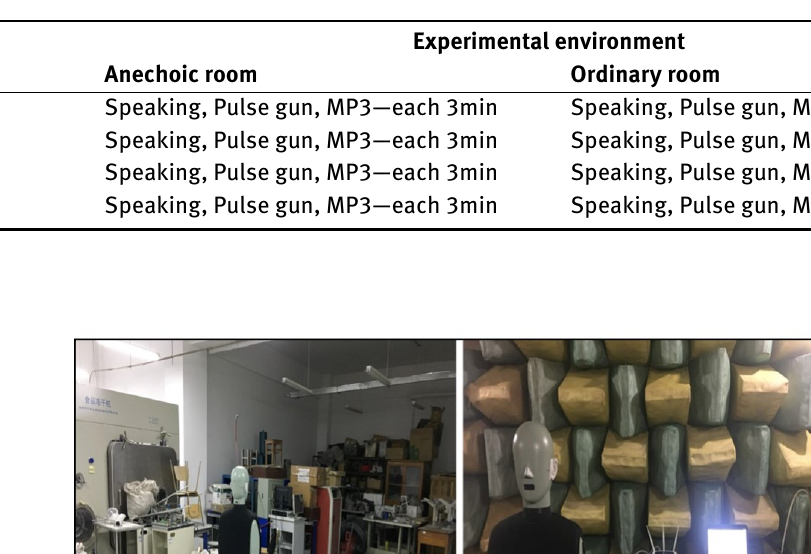
Table 1: The type and duration of the audio.